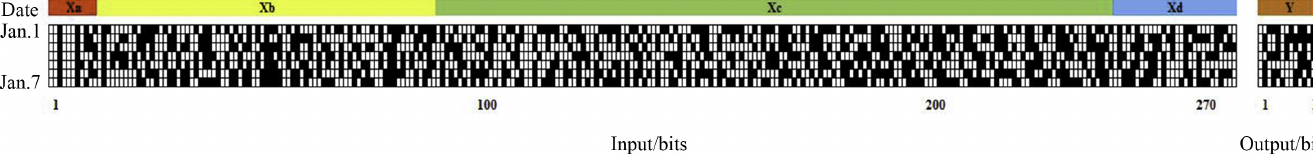
Fig 2. Inputs and outputs for forecasting the load at 1:00 from Jan. 1 to Jan. 7, 2004, for Zone 1 (in binary format). The top of the figure denotes the category of the input/output of the model: Xa denotes the calendar information (year, month, holiday, and weekday), Xb denotes the temperature, Xc denotes the historical temperature, Xd denotes the historical load, and Y denotes the